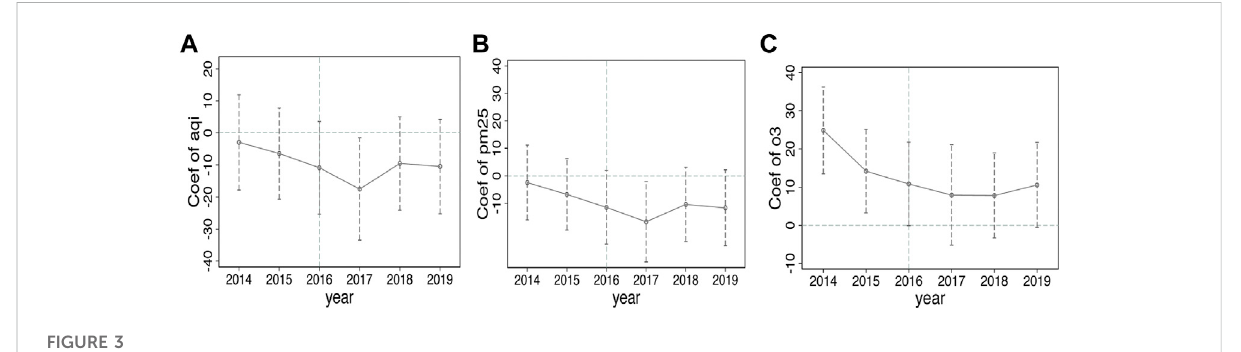
FIGURE 3 Parallel trend hypothesis test.